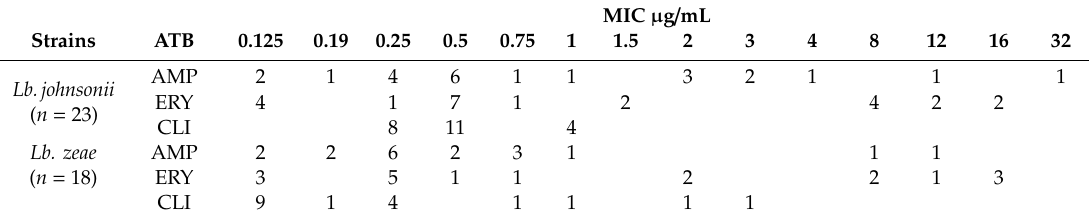
Table 3. MIC determination of test isolates by E-test.